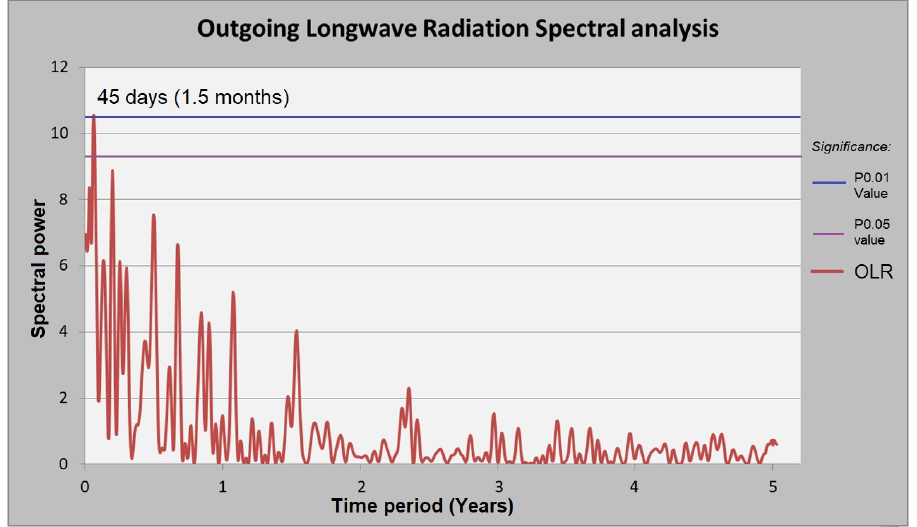
Figure 9. Spectral analysis of the OLR for the period 1999–2014 on a daily scale. P 0.01 (red line) in value 10.7 and P0.05 (purple line) in 9.1.